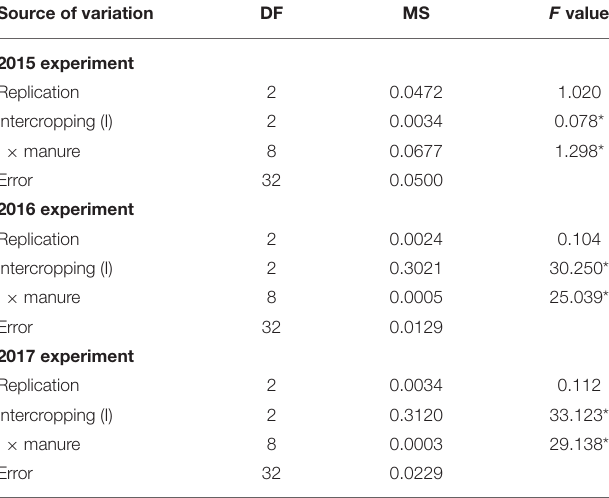
TABLE 4 | Analysis of variance for the land equivalent ratios (LERs) in the yield of cowpea–sorghum intercrop and their respective pure